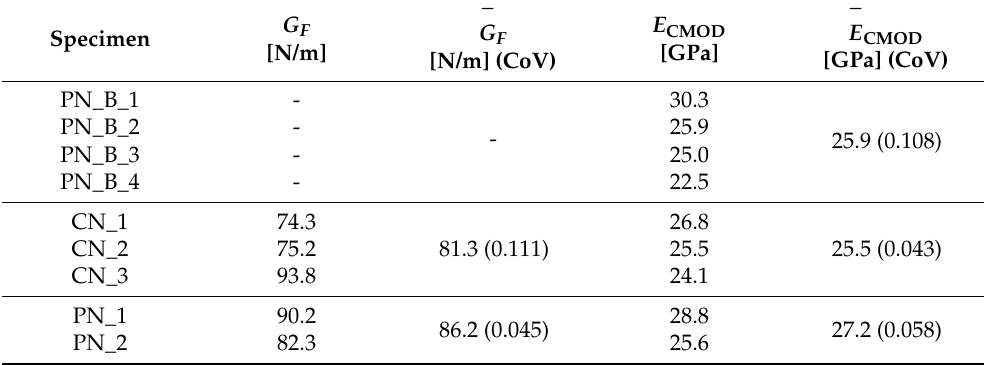
Table 3. Fracture energy ( G F ) and elastic modulus ( E CMOD ) from CMOD.